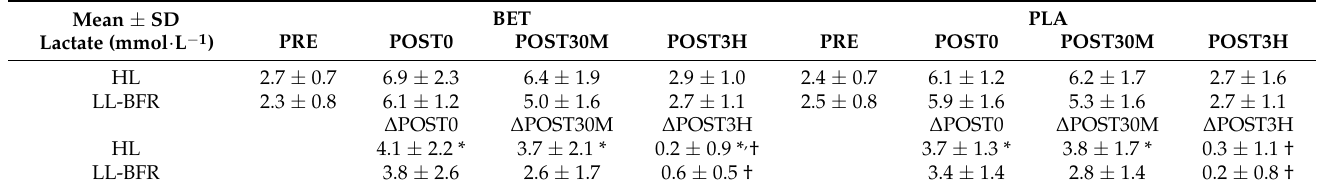
Table 4. Raw lactate and ∆ Lactate (change from rest/baseline) concentrations (nmol/L). All data are presented as means ±